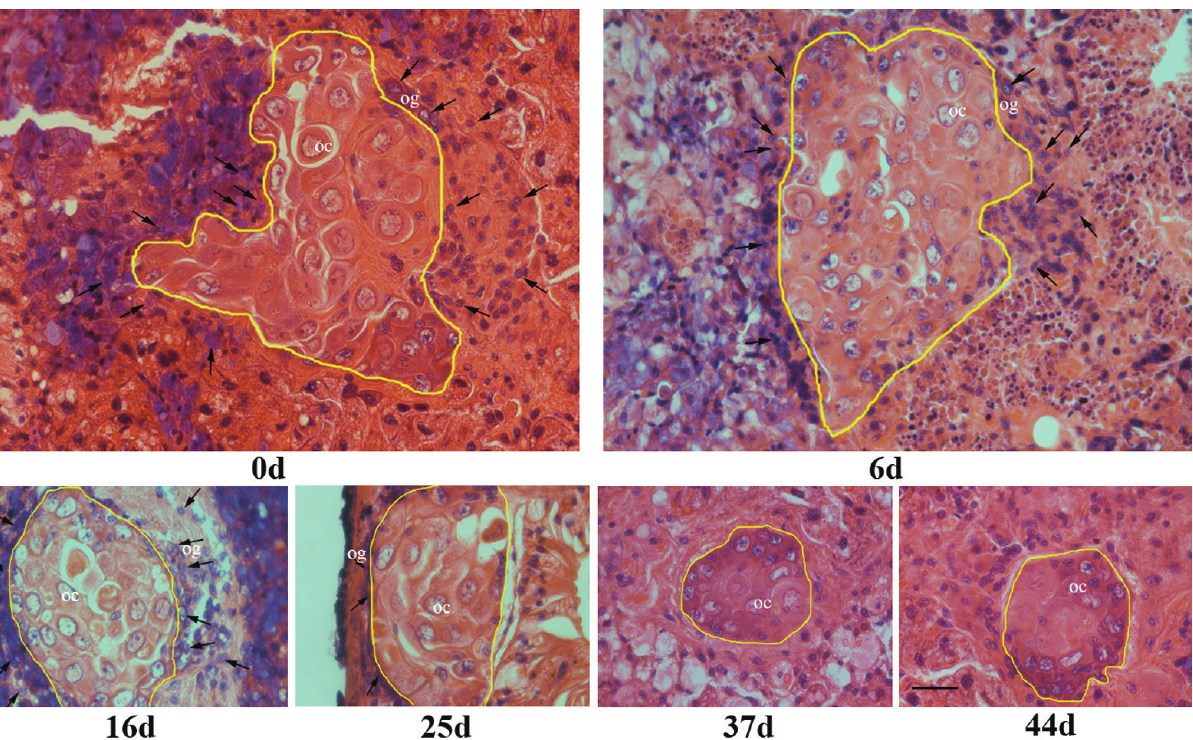
Figure 1. Histological changes of the ovary during starvation. The ovary of on the day 25 th is sagittal section and the others are horizontal section. The yellow lines indicate the innermost region and the oogoniums marked by black arrows, d: days after starvation, og: oogo- nium, oc: oocyte. Scale bar: 200